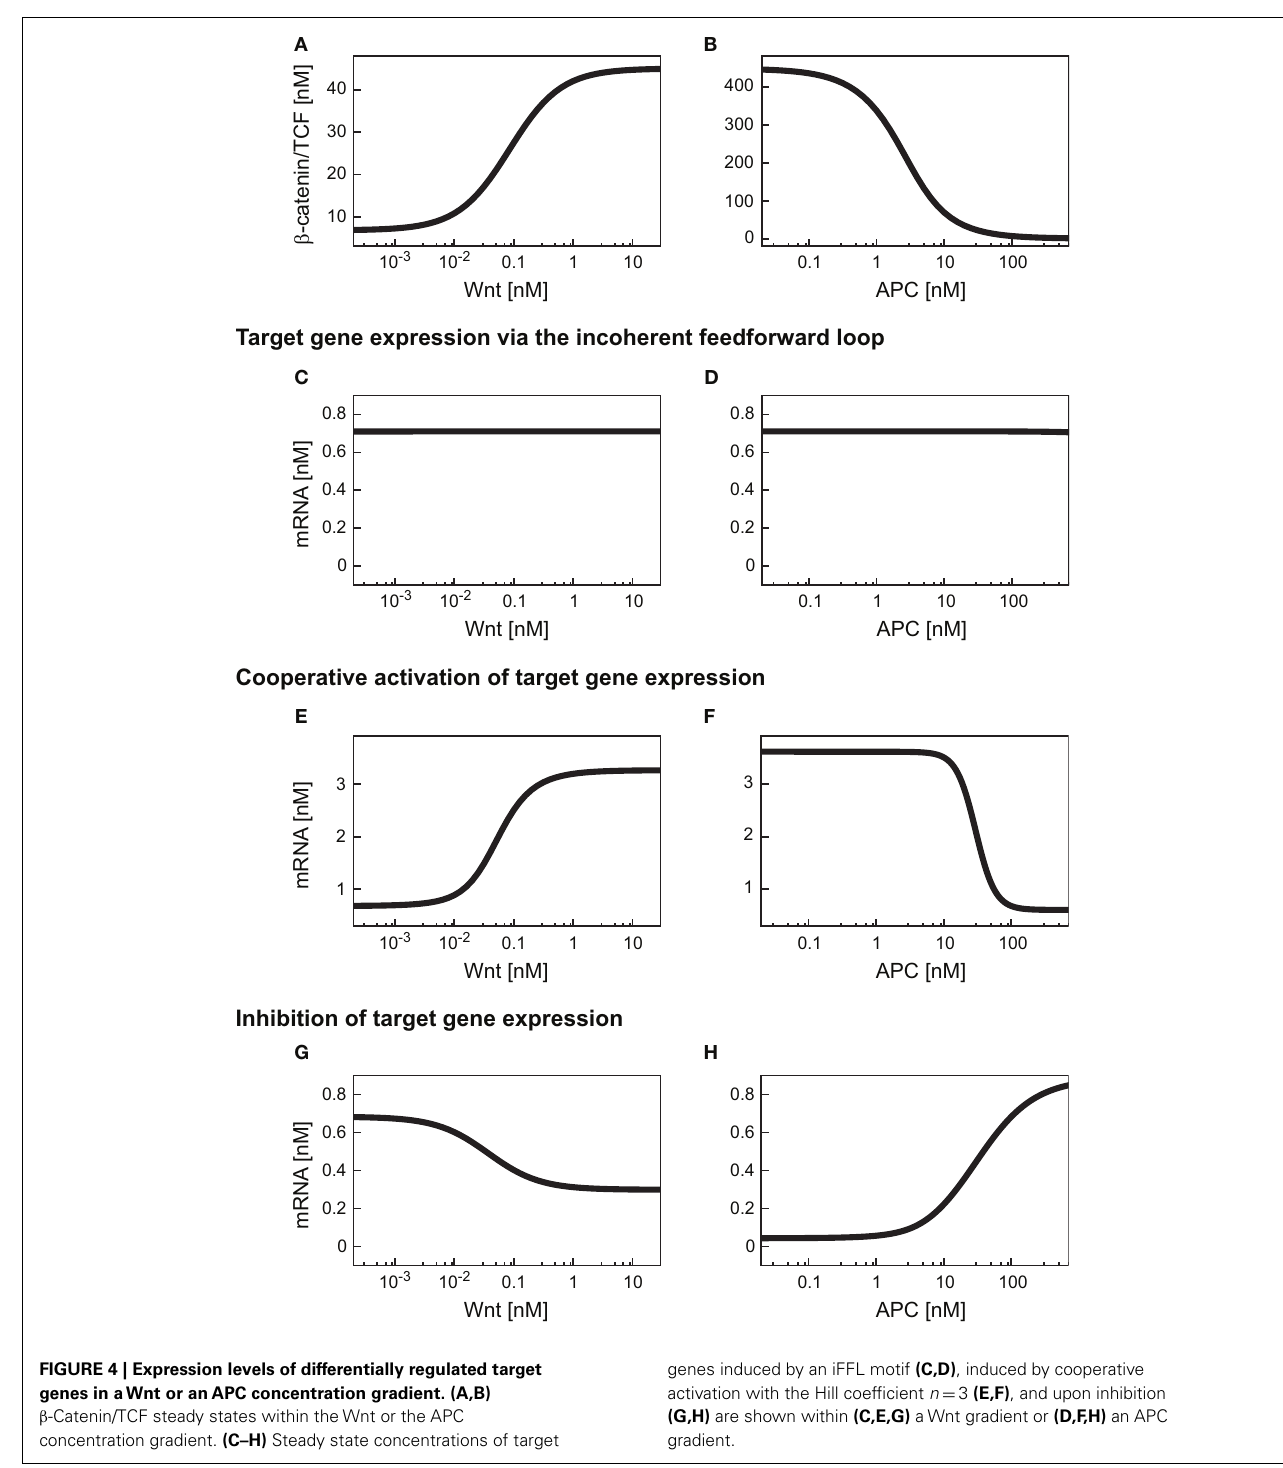
integrated an inhibitory function in the rate of transcription